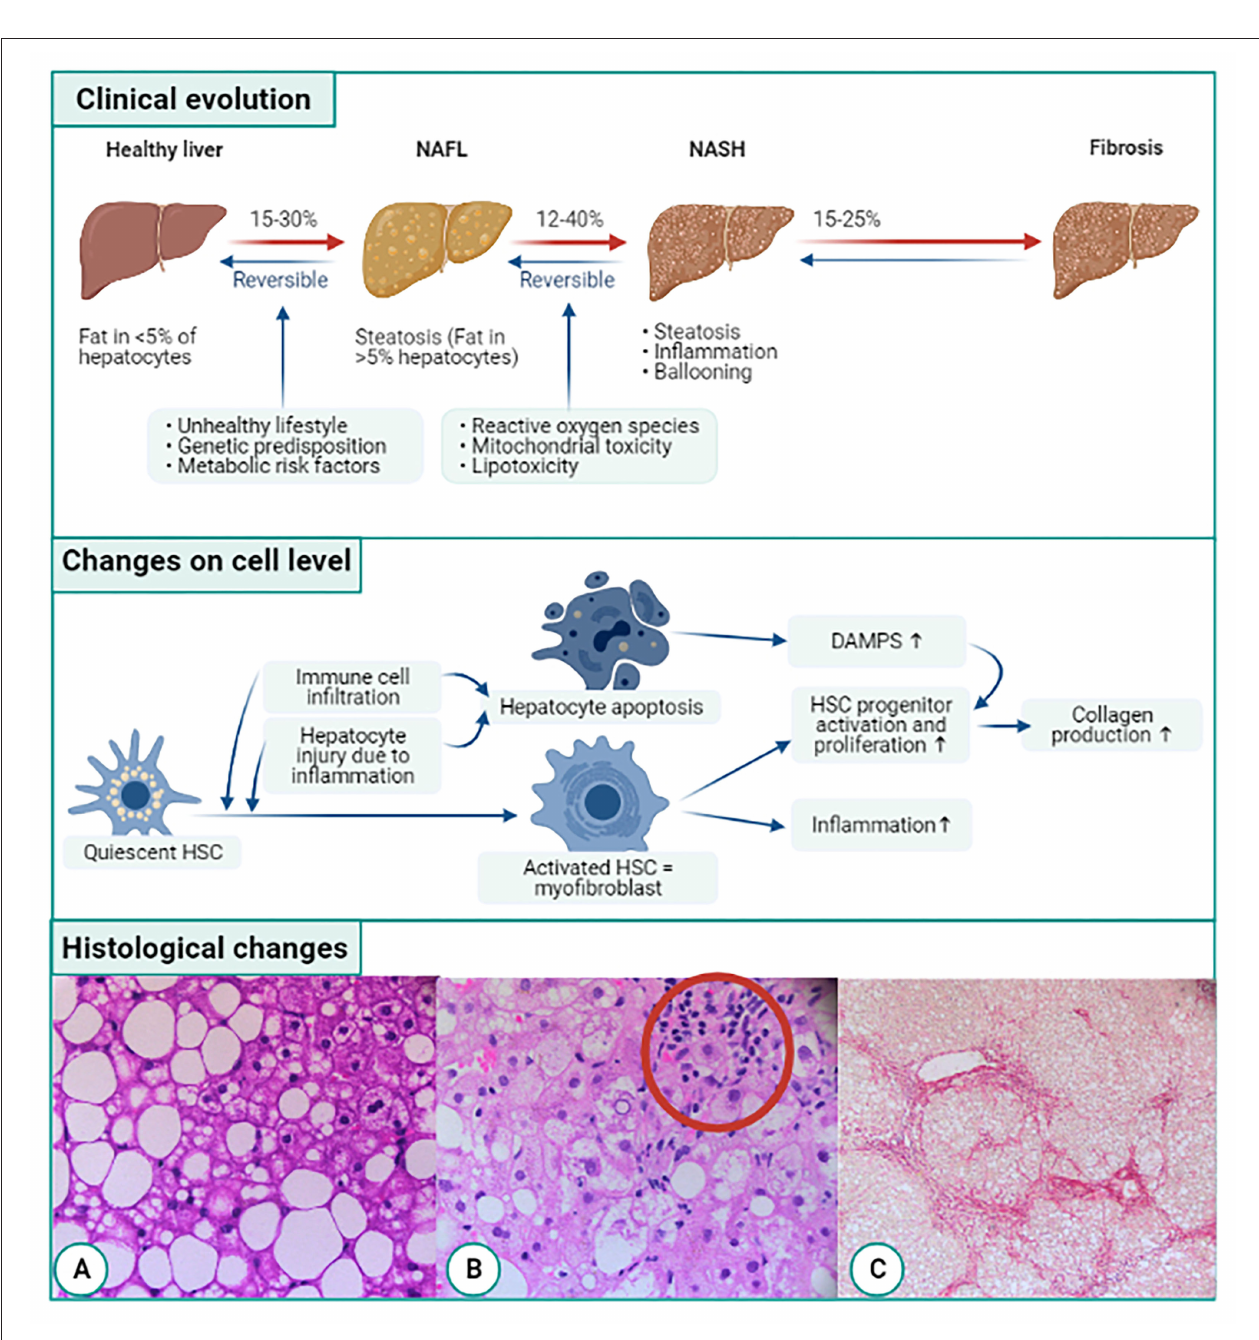
FIGURE 1 | Overview of evolution of NAFLD related fibrogenesis on clinical, cellular, and histological level. On the clinical level NAFLD starts of as simple steatosis (NAFL). The abnormal amount of liver fat triggers inflammation by infiltrating immune cells and secretion of cytokines. This is called non-alcoholic steatohepatitis or NASH which can cause liver fibrosis. On cellular level, quiescent hepatic stellate cells (HSCs) are activated by immune cell infiltration and hepatocyte injury due to inflammation. The activated HSC transdifferentiates into collagen producing myofibroblasts furthermore the myofibroblasts trigger HSC progenitor proliferation and activation. Another consequence of the immune cell infiltration and hepatocyte injury is apoptosis of hepatocytes, leading to the release of damage-associated patterns (DAMPs). DAMPs also activate hepatic progenitor cells. Both the myofibroblasts and HSCs will start producing collagen. On a histological level, first fat accumulates in the liver (A). This leads to the infiltration of immune cells (B) and ballooning and eventually liver fibrosis occurs (C). Histological pictures courtesy of Dr. P. Van Eyken, pathologist, Ziekenhuis Oost-Limburg, Genk, Belgium. in organ dysfunction and leads to the deposition of fibrotic tissue infiltration is often seen in histologic samples of NASH patients in parallel to the cell loss (31). These immune responses comprise ( Figure 1B ). Additionally, patients with NASH and advanced fibrosis related to NASH have a higher both innate and adaptive responses (32). For example, neutrophil